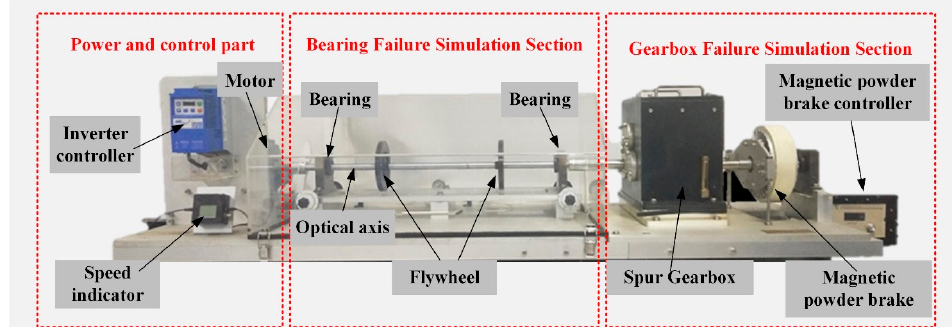
Figure 10. Comprehensive fault simulation test bench. Table 2. Structural parameters of the ER − 16K bearing.